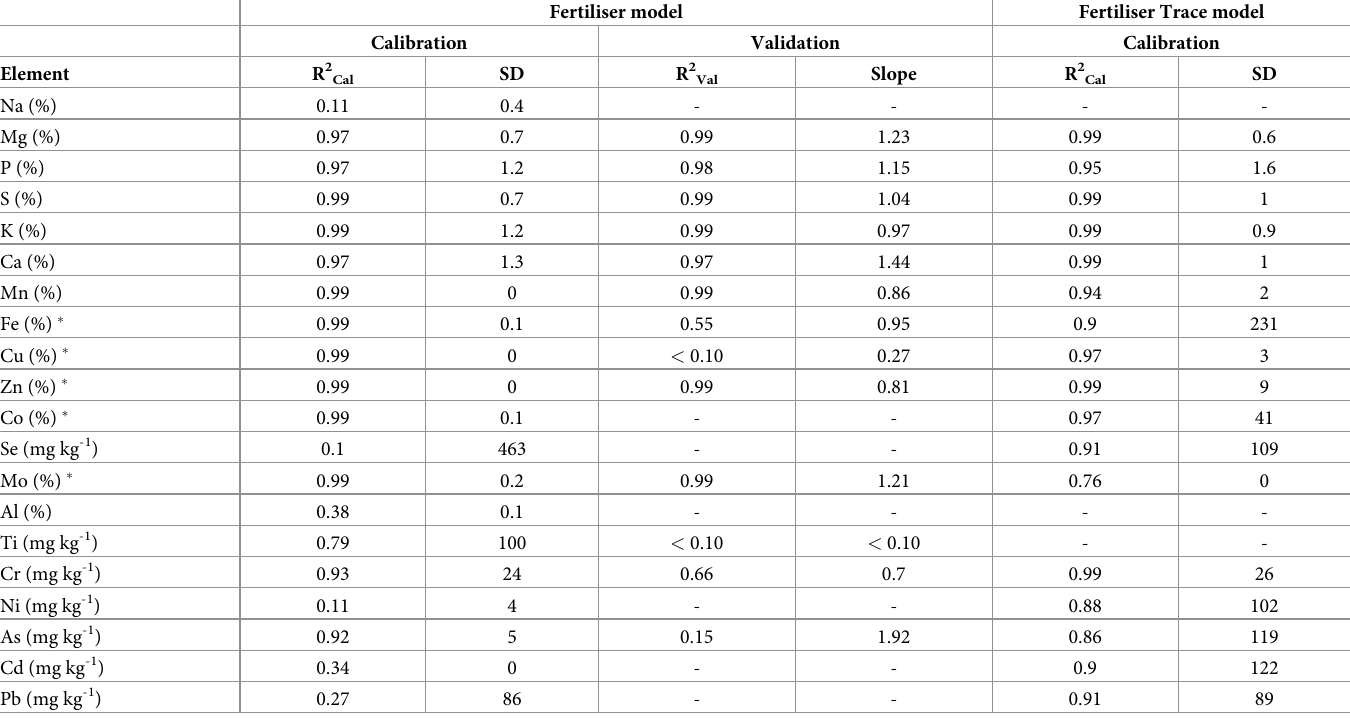
Table 6. Goodness of fit parameters for empirical pXRF “Fertiliser” and “Fertiliser Trace”